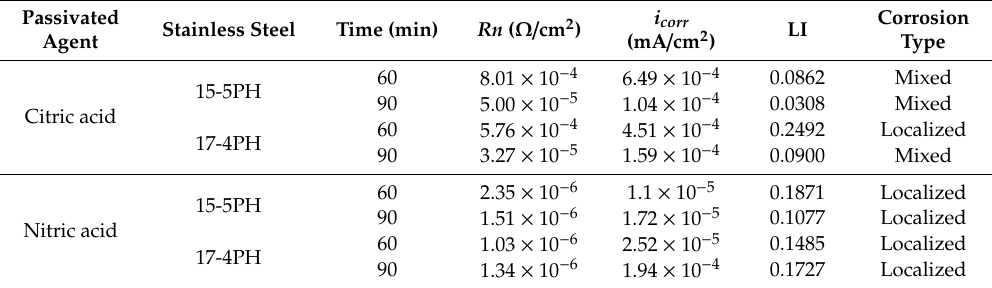
Table 3. Electrochemical noise parameters at various conditions in 5 wt. % NaCl at 49 ◦